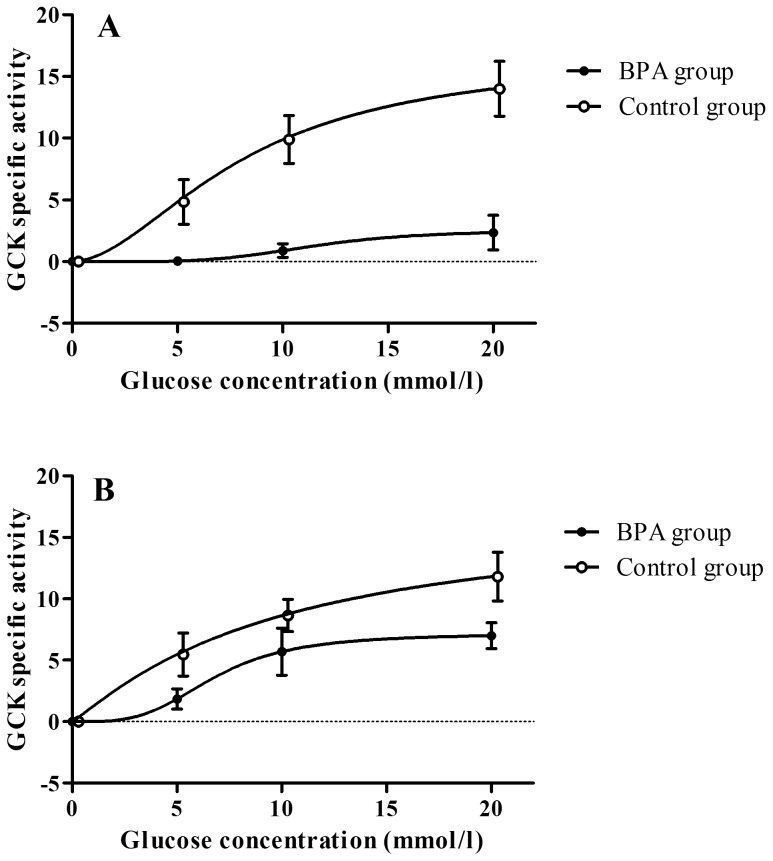
Glucokinase specific activity at different glucose concentrations (range 0–20 mmol/l) in mice 2 hours after acute BPA exposure (A; overall treatment effect p<0.001) or after 2 weeks chronic BPA exposure (B; overall treatment effect p = 0.003).